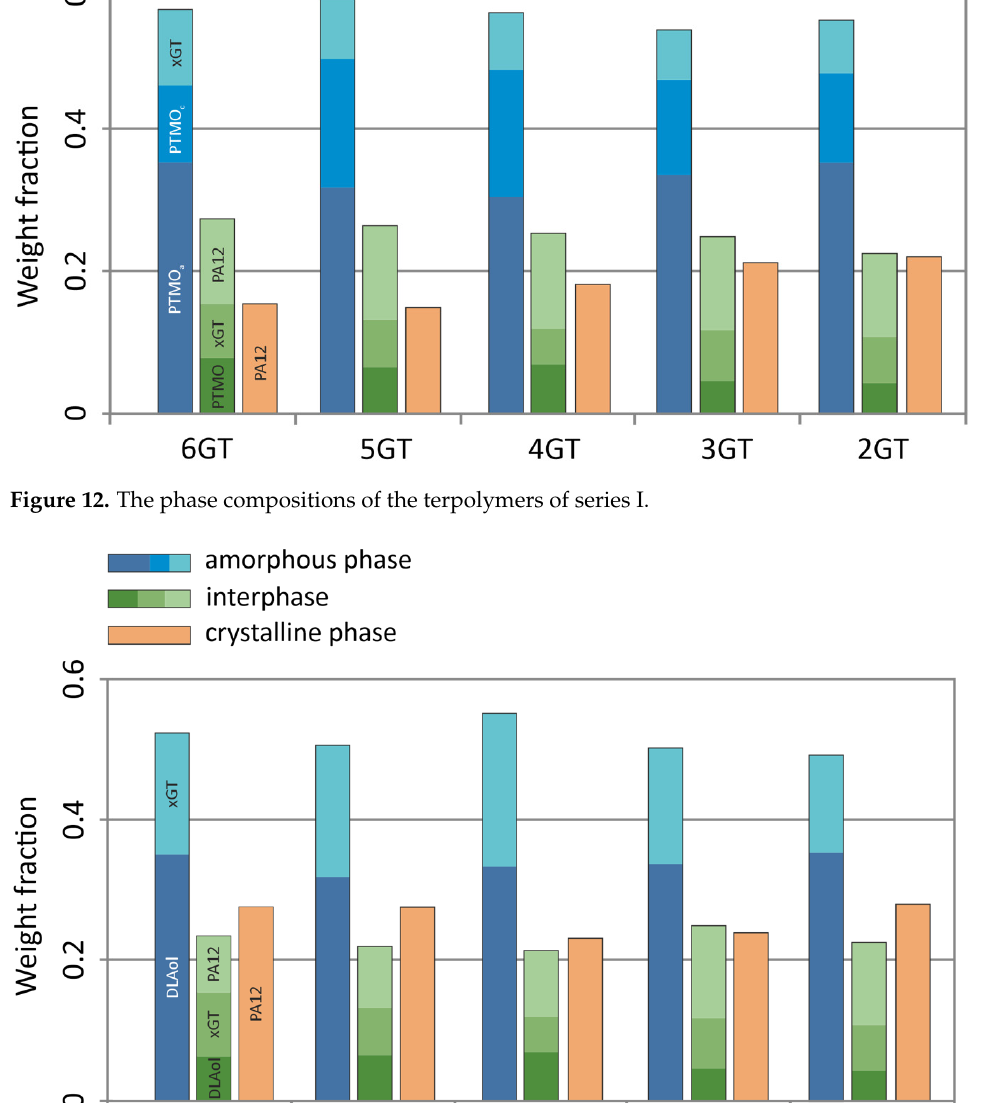
Figure 12. The phase compositions of the terpolymers of series I.